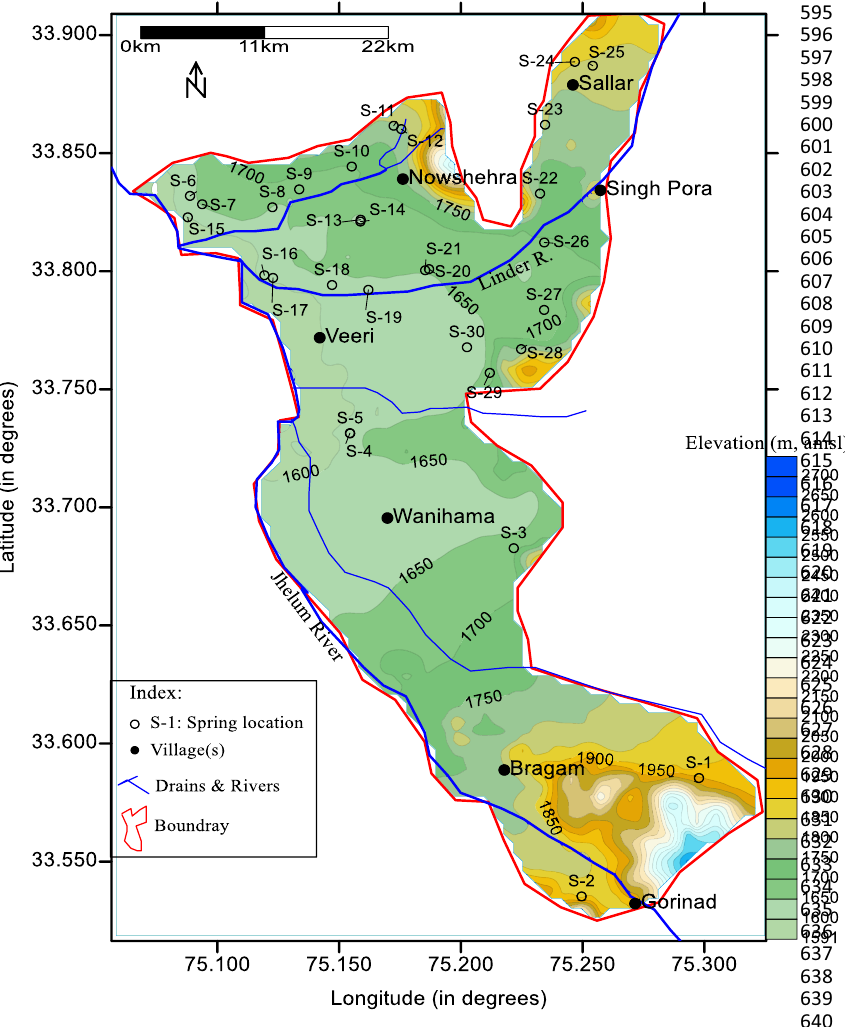
Fig. 2 Spring location on the basis of altitude in Anantnag district, Kashmir